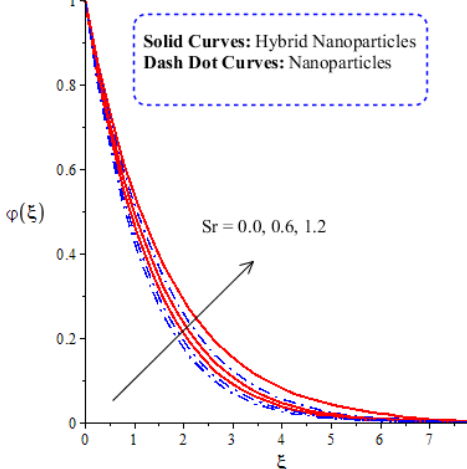
Figure 16. Comparative analysis of concentration in hybrid nanoparticles and nanoparticles with changes in 𝑆𝑟.